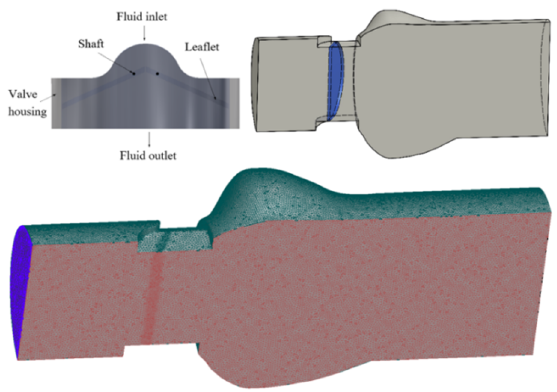
Figure 1. Structure of mechanical heart valve and grid partition.